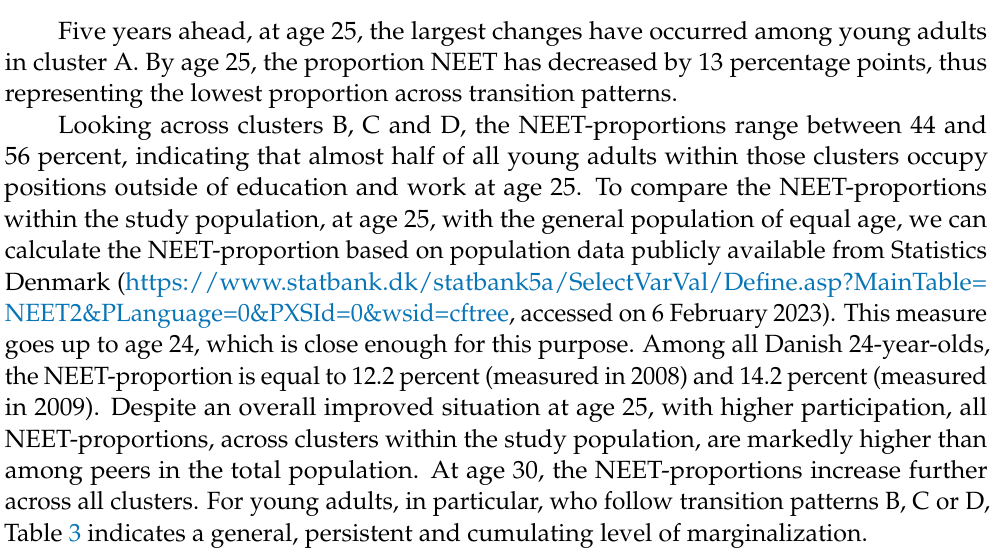
Table 3. Cross-sectional distributions of NEET proportion by cluster (transition patterns) measured at month 60 (age 20), age 25 and age 30. NEET Proportions within the NEET Proportion within the Study Population Total Population Cluster Age 20 Age 25 Age 30 Age 24 A 45% 32% 39% 12–14%B 53% 44% 53% C 63% 56% 58% D 56% 51%